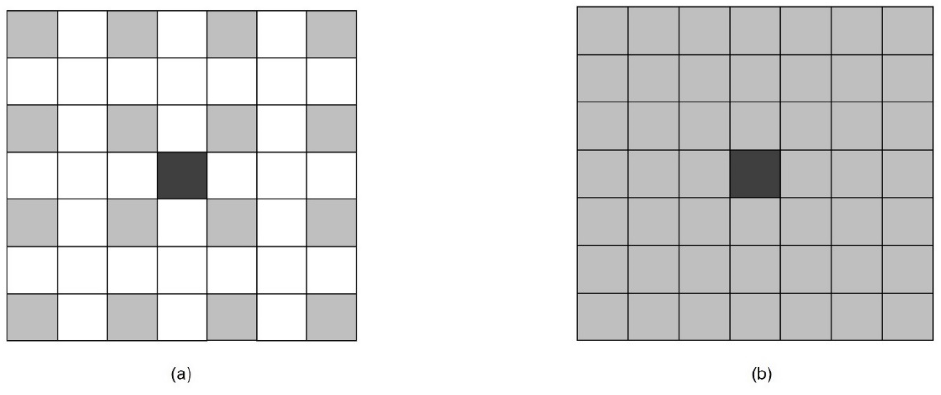
Figure 1. Two types of support windows. ( a ) Sparse type; ( b ) common type. To combine the advantages of graph cuts and adaptive weights, based on the adaptive weight method, we first use the color and distance similarity between the pixels in the support window and the center pixel to segment each pixel in the support window. If the pixel satisfies the set conditions, it is determined that it belongs to the same segmentation unit as the center point, and the maximum weight value 1 is assigned to it; if not, it is determined according to the color and distance similarity between the two pixels. Assigning weights, that is, the complexity of the improved adaptive weighting algorithm, remains unchanged. The rule for judging whether it belongs to the same division unit as the center point is shown in Equation (23).